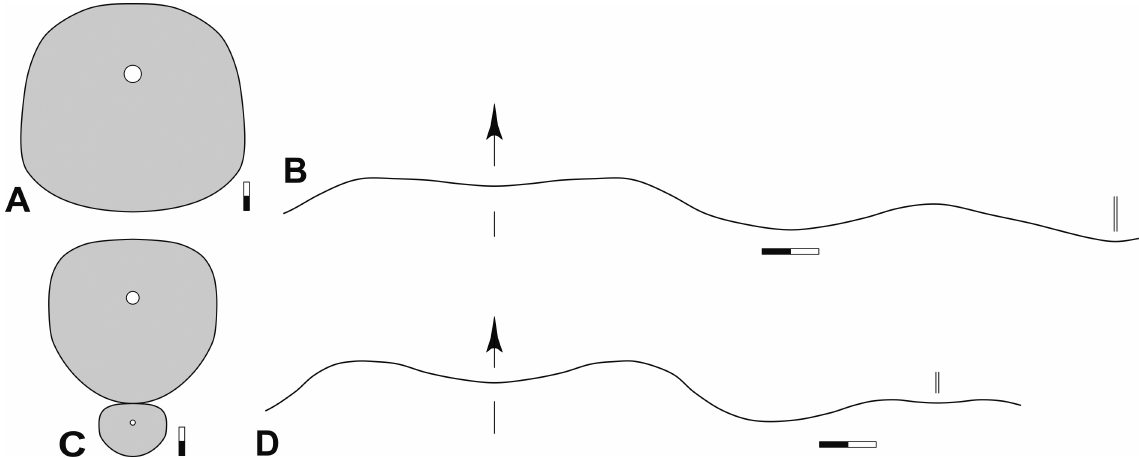
Fig. 27. Maccoyoceras saharensis sp. nov. from Oued Temertasset (both Korn et al . 2002 Coll.). A . Whorl profile of holotype MB.C.30480.1. B . Suture line of holotype MB.C.30480.1, at ww = 16.2 mm, wh = 14.8 mm. C . Whorl profile of paratype MB.C.30481. D . Suture line of paratype MB.C.30481, at ww = 10.9 mm, wh = 14.8 mm. Scale bar units = 1 mm.